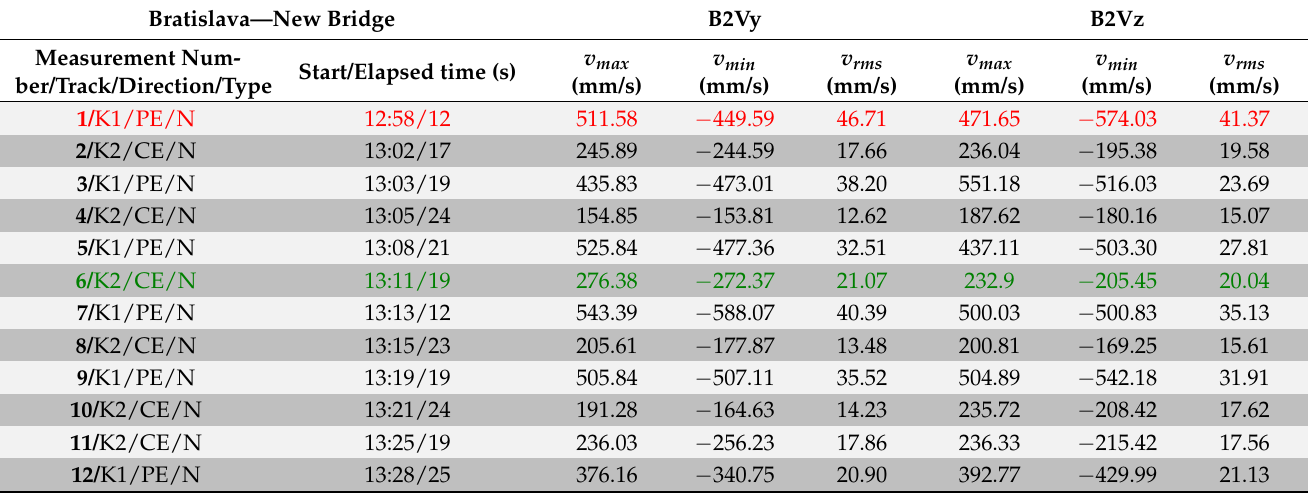
Table 8. Amplitude characteristics from time records of vibration velocity at points B2Vz and B2Vy .